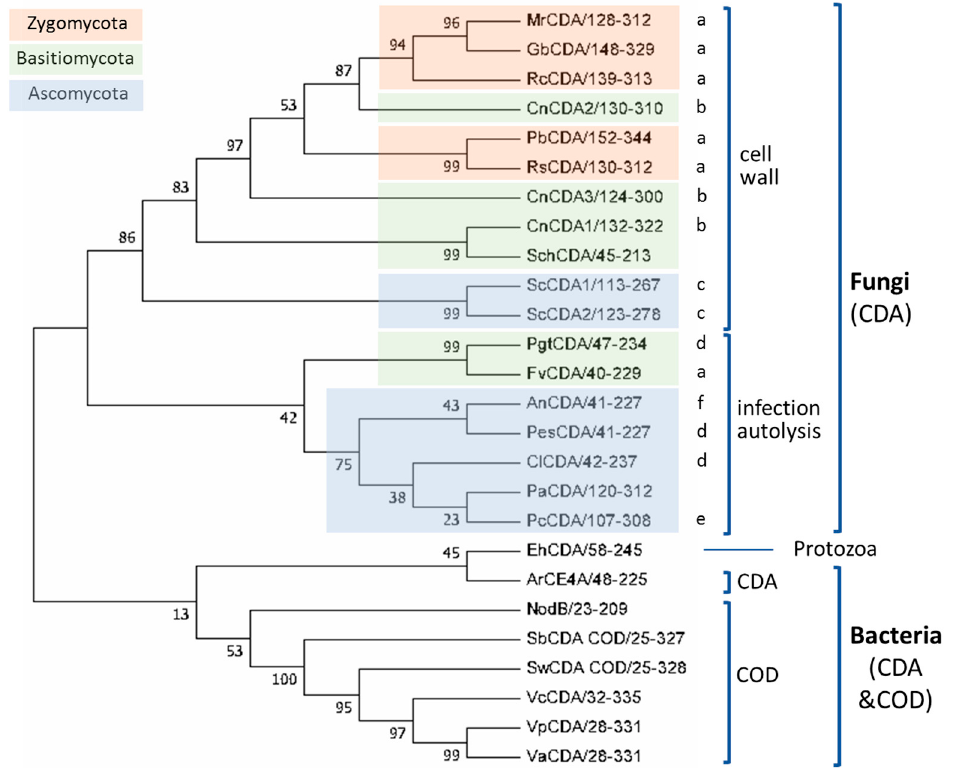
Figure 4. Phylogenetic analysis of CDAs from the multiple sequence alignment presented in Figure 3. A bootstrap analysis with 500 replicates was carried out on the trees inferred from the neighbor joining method. The consensus tree is shown with bootstrap values at each node of the tree. Biological functions: cell wall biosynthesis: (a) cell wall, (b) vegetative growth, (c) sporulation; host infection, (d) defense, (e) interaction/infection, (f) autolysis (see text).